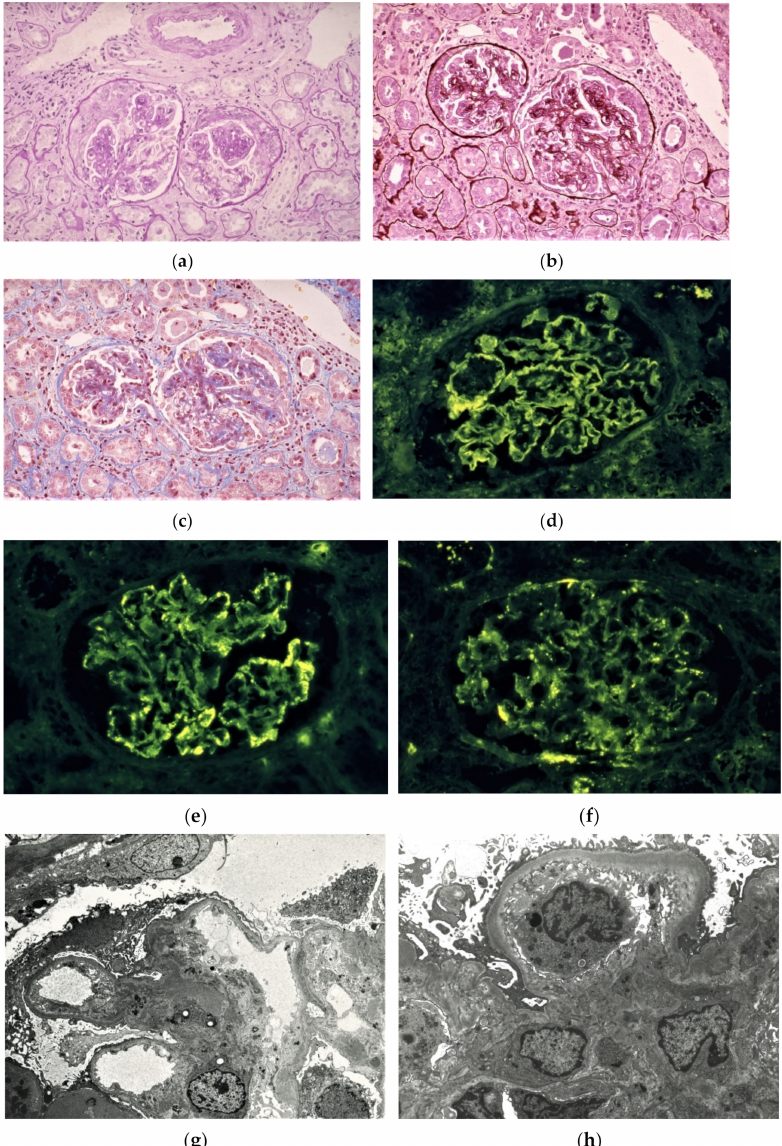
Figure 1. Histological findings of SAGN with IgA-dominant deposition. Light microscopy images of renal biopsy samples stained with periodic acid Schiff ( a ), periodic acid methenamine silver ( b ), and Masson’s Trichrome ( c ); 400 × magnification. The images ( a – c ) show mesangial and endocapillary proliferative glomerulonephritis with crescent formation and tubulointerstitial nephritis. ( d – f ) Im- munofluorescence images of renal biopsy samples stained with anti-IgG ( d ), anti-IgA ( e ), and anti-C 3 ( f ) antibodies, showing IgG, IgA, and C 3 deposition in the mesangium and along the glomerular capillary walls. Electron microscopy images of renal biopsy samples ( g , h ) show electron-dense deposits in the mesangial and subendothelial